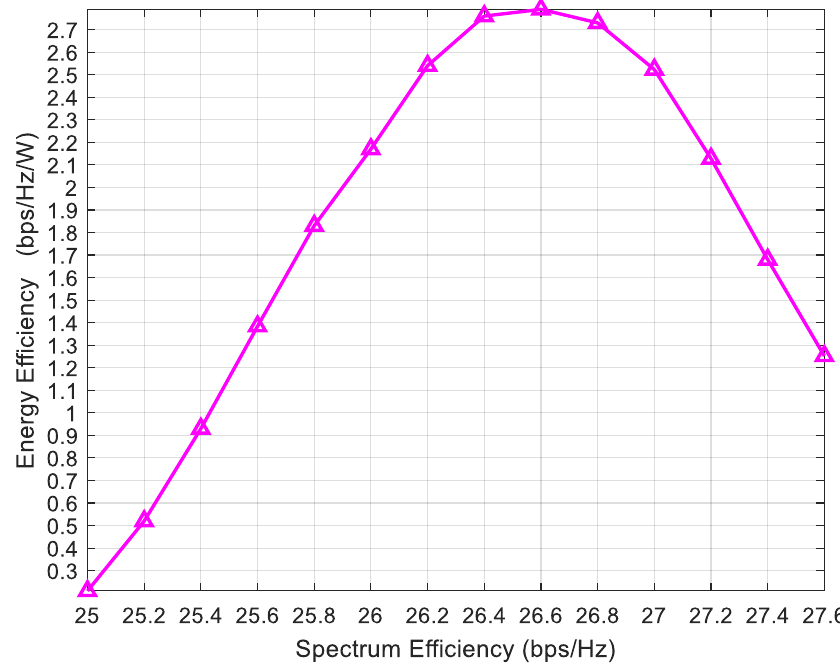
Figure 8. The SE – EE relationship for the proposed system. Figure 8. The SE–EE relationship for the proposed